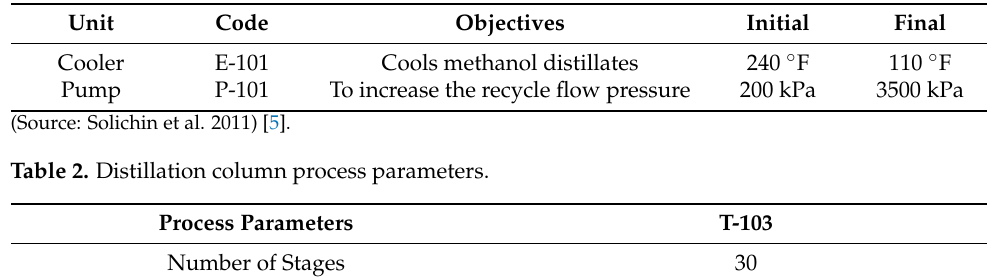
Table 1. Cooler and pump process parameters.